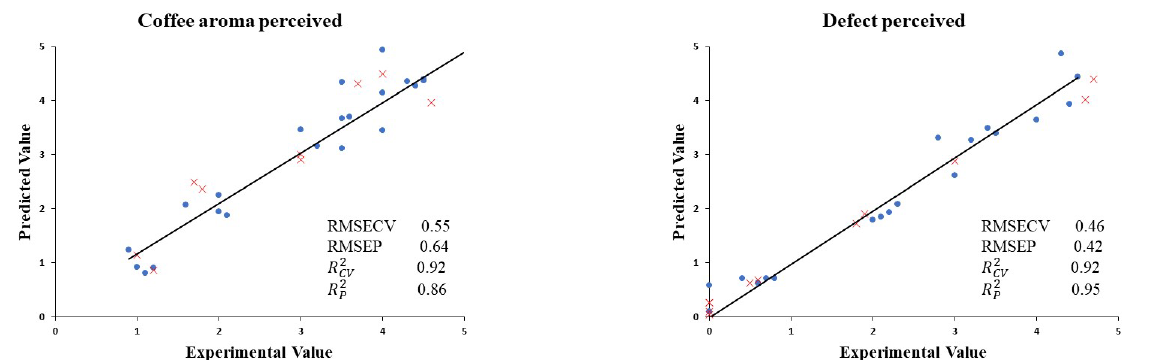
Figure 7. Experimental values against PLS cross-validation predictions ( • ) and validation set predictions (x) for coffee bean aromas and defect aromas perceived by panelists.